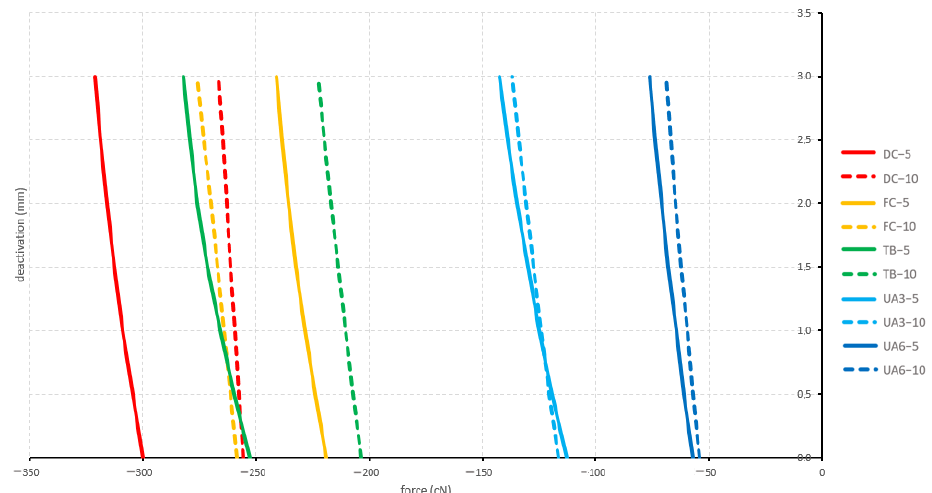
Figure 10. Sagittal forces generated by the straight configurations during deactivation (protrusion positive; retraction negative). Tested cantilever configurations origin from Figure 2.